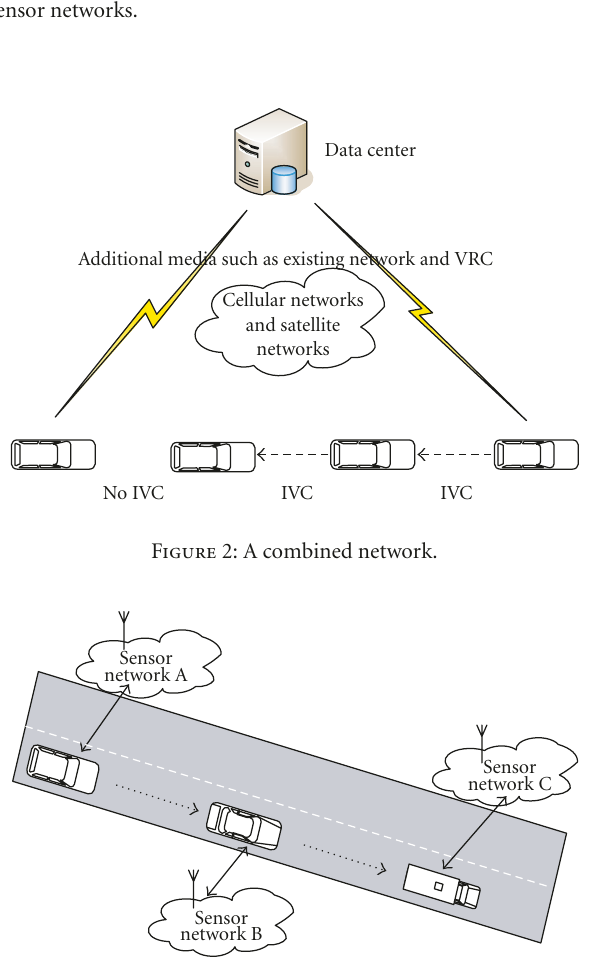
Figure 3: Using VMesh to connect disjoint sensor